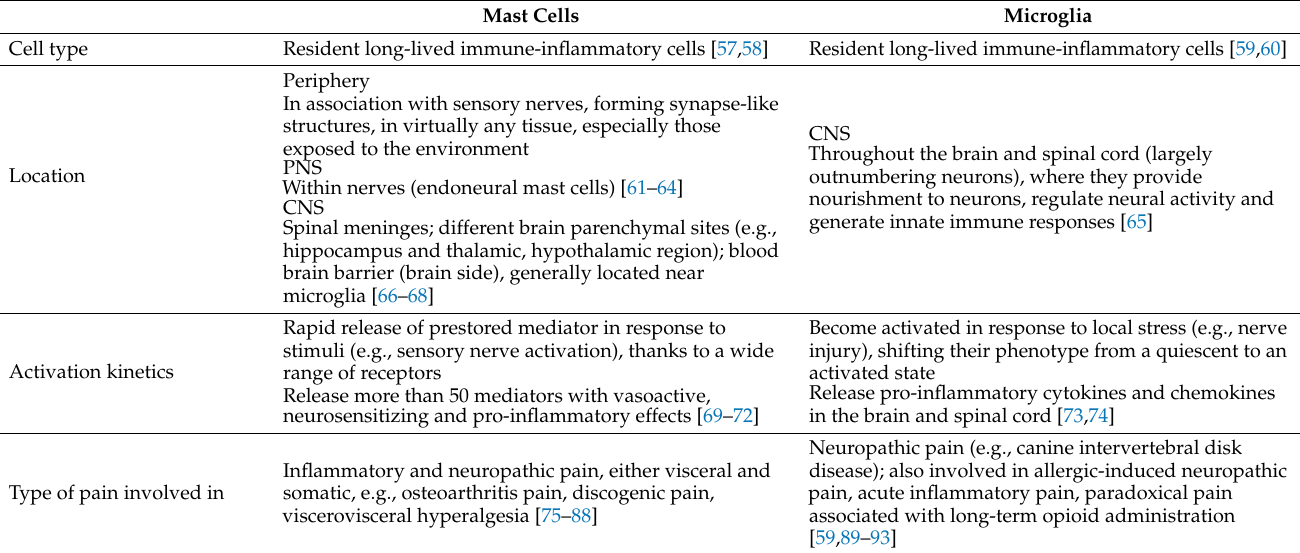
Table 1. Mast cell and microglia ID